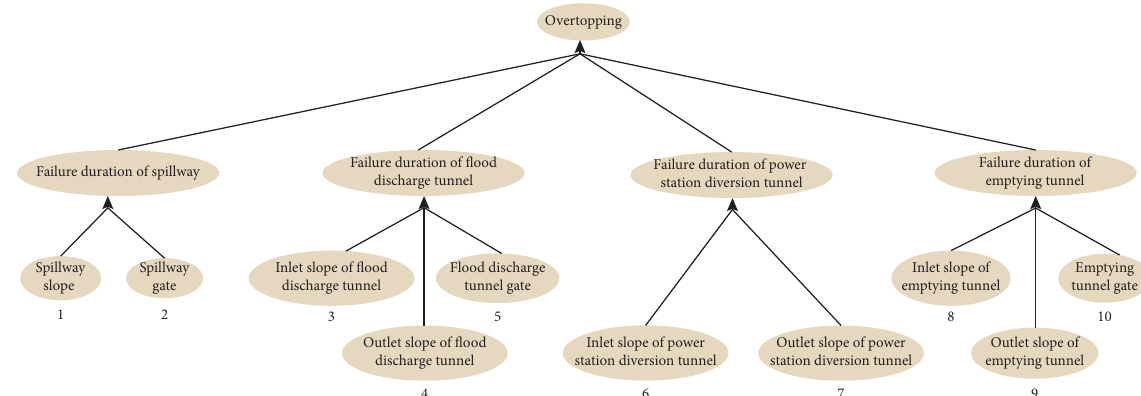
Figure 6: Bayesian network model for overtopping risk analysis of the PBG